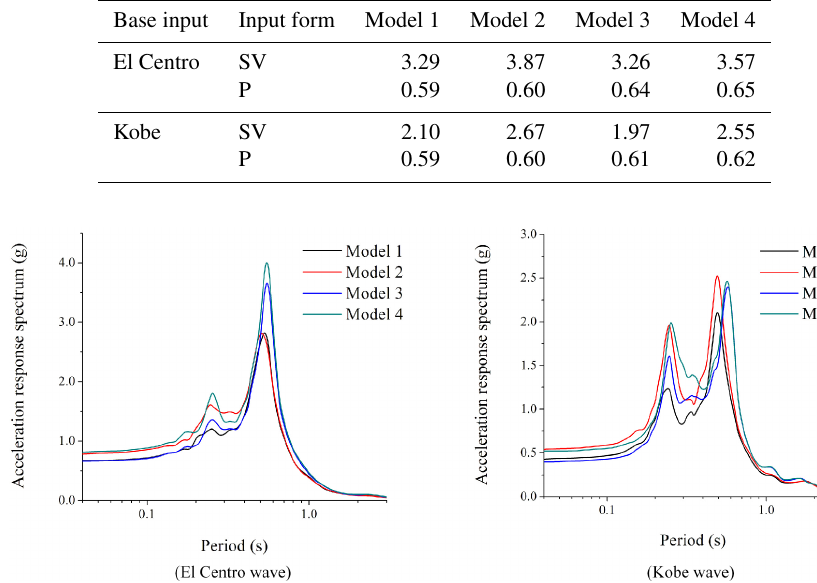
Table 3. Peak amplification coefficient β of monitoring point A.